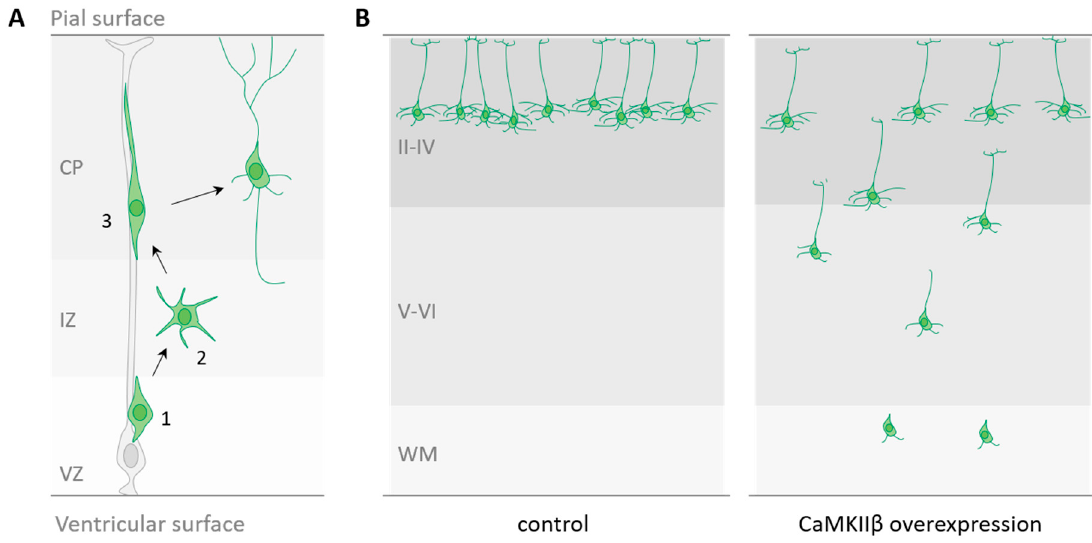
Figure 2. ( A ) Radial migration of projection neurons in the developing cerebral cortex. Step 1: newborn neurons detach from the ventricular surface. Step 2: nascent neurons migrate into the intermediate zone where they become transiently multipolar. Step 3: newborn neurons undergo a multipolar-bipolar transition and migrate along radial glia processes to finally detach and populate the cortical plate. VZ: ventricular zone; IZ: intermediate zone; CP: cortical plate. ( B ) Cortical neuron position in the early postnatal cortex in control condition of after CaMKII β overexpression. II-IV: layers II to IV; V-VI: layer V and VI; WM: white matter.